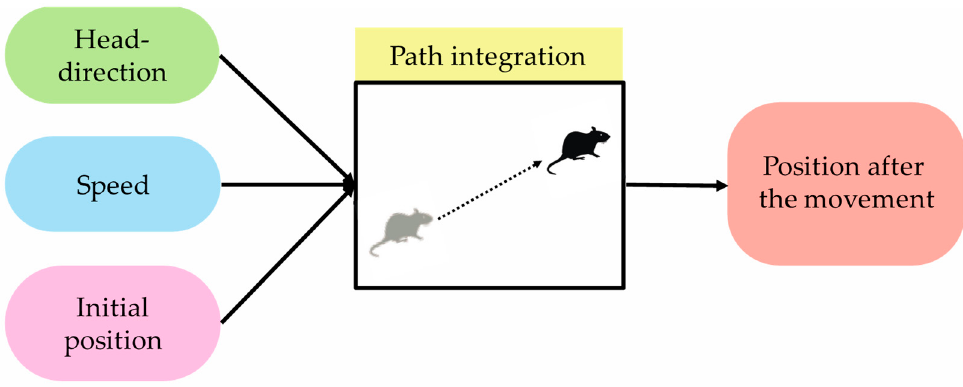
Figure 2. Input and output information that is necessary for path integration. During animal movement in path integration, when initial-position and movement information (head-direction and speed information) is input, position information after movement is output.